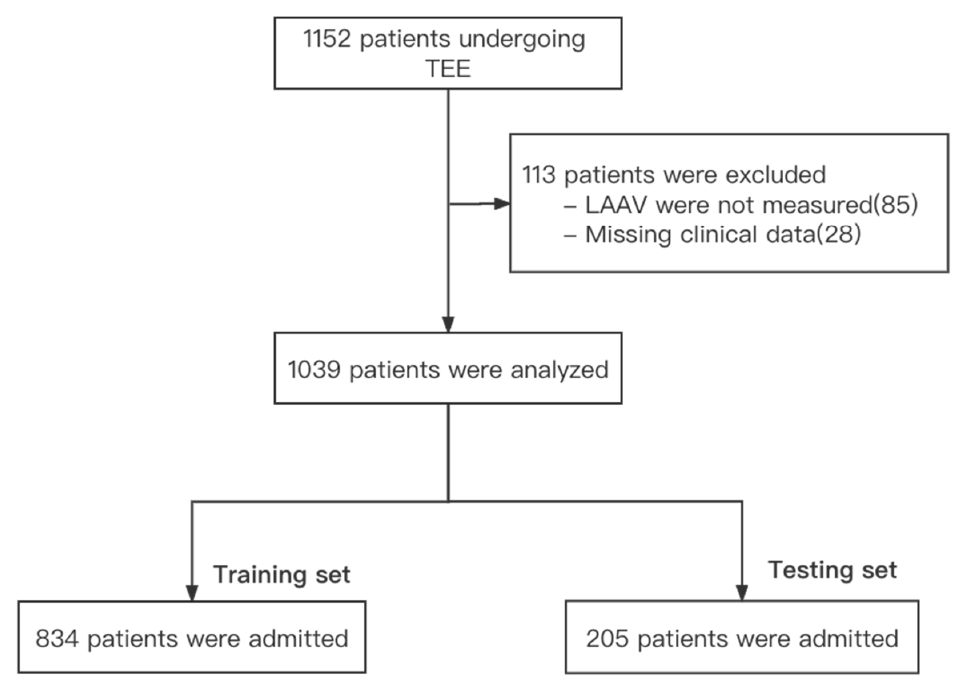
Figure 1. Flow diagram. TEE: transesophageal echocardiography; LAAV: left atrial appendage flow velocity.